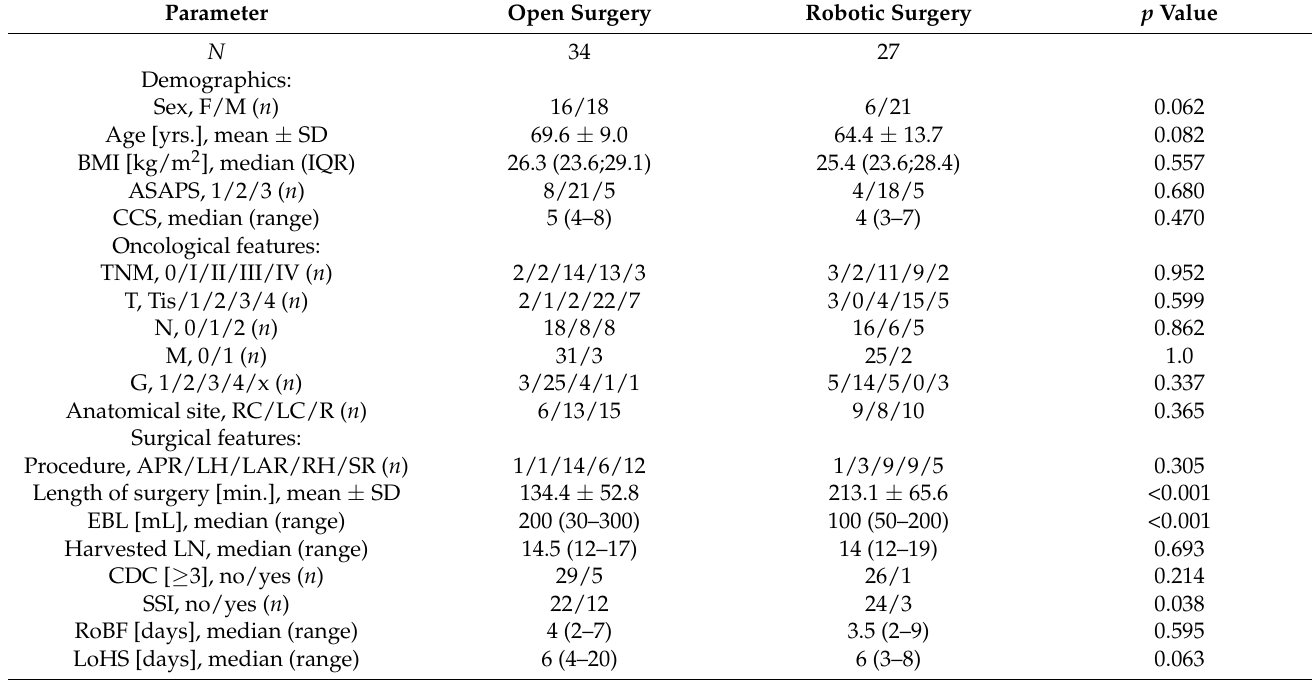
Table 2. Characteristics of study population